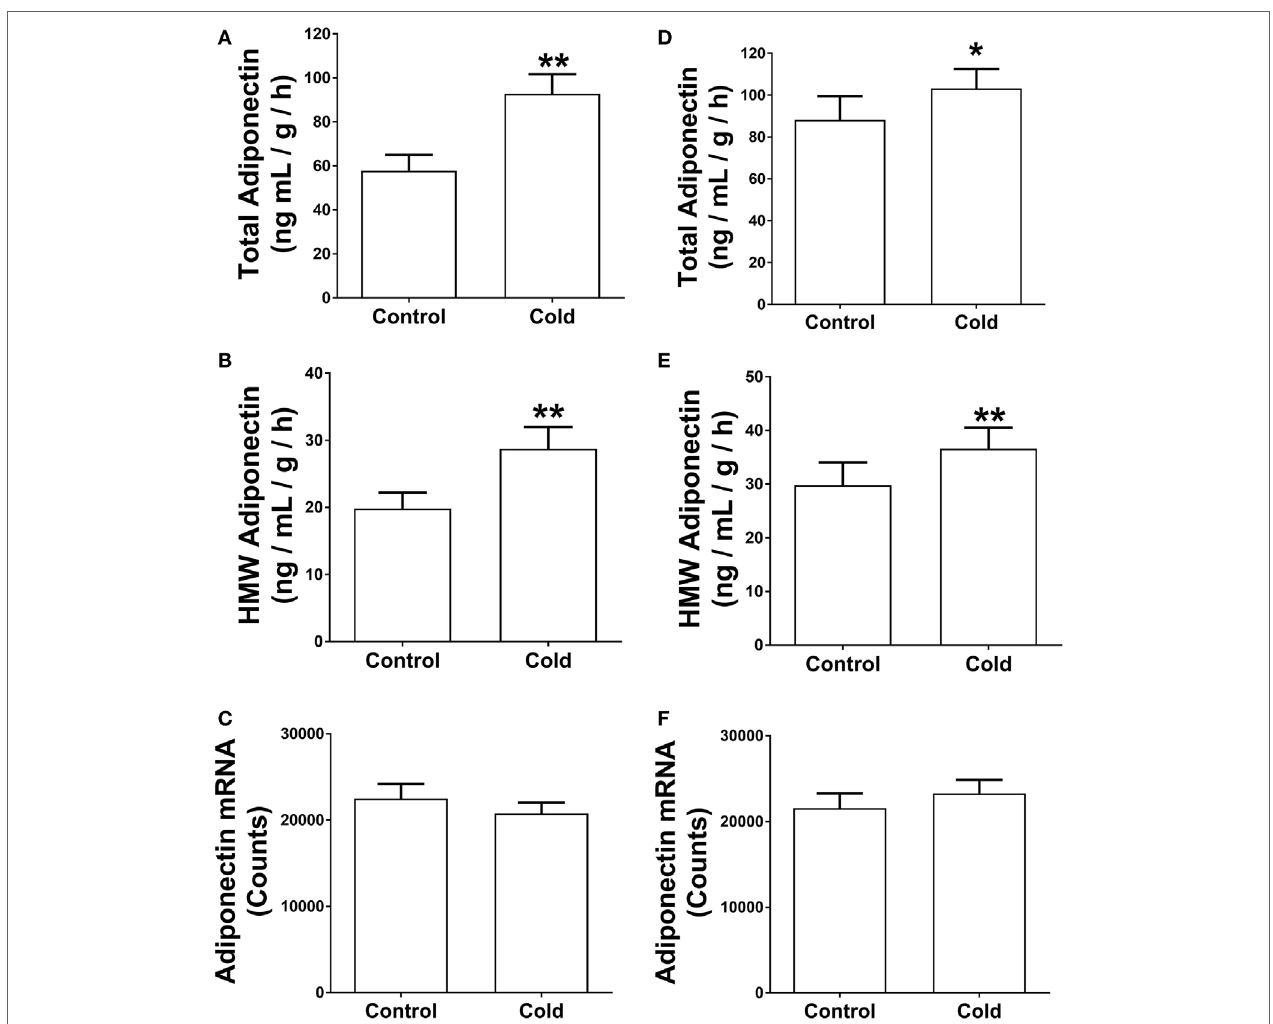
FiGUrE 4 | Cold induces total and high-molecular weight (HMW) adiponectin secretion by adipose tissue explants of obese, insulin-resistant subjects. Adipose tissue explants obtained before and after cold treatment (30 min) before and after KDT501 treatment were incubated in Dulbecco’s modified Eagles’ medium (DMEM) for 4-h at 37°C. (a) Total and (B) HMW adiponectin secretion in the DMEM were measured by ELISA and are expressed as the concentration/g adipose/h. (C) Adiponectin gene expression was measured in the corresponding adipose tissue biopsy with the Nanostring nCounter system as described in the Section “Materials and Methods.” (D) Total and (E) HMW adiponectin secretion in the DMEM were measured by ELISA. (F) Adiponectin gene expression was measured in the corresponding adipose tissue biopsy with the Nanostring nCounter system as described in the Section “Materials and Methods.” Data represent the mean ± SEM ( n = 9); data in all panels were analyzed by a paired, two tailed Student’s t -test (* P < 0.05; ** P <